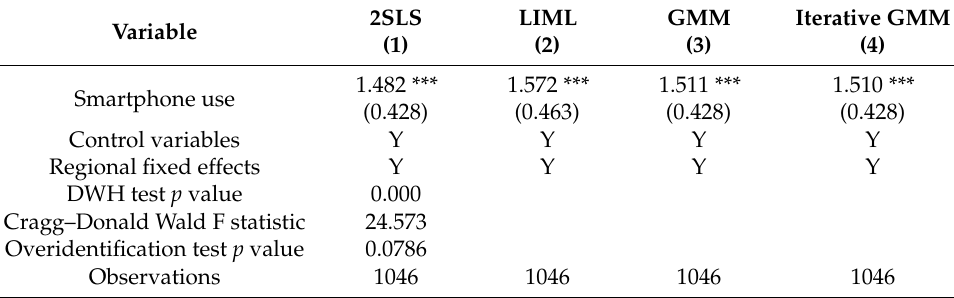
Table 4. Instrumental variable